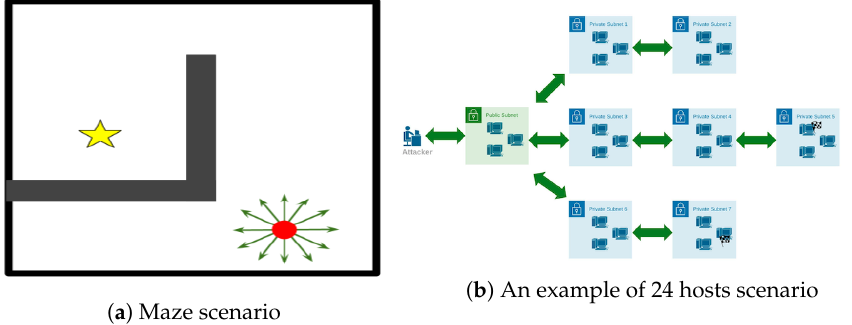
Figure 5. Two simulated scenarios. ( a ) A toy-maze-based scenario. ( b ) A CybORG scenario of 24